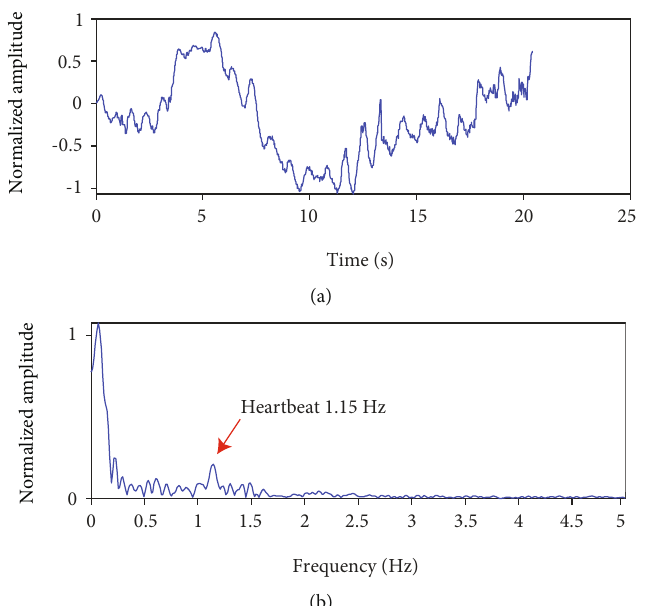
Figure 14: The demodulation result when using adaptive anti-interference algorithm. (a) In time domain. (b) In frequency